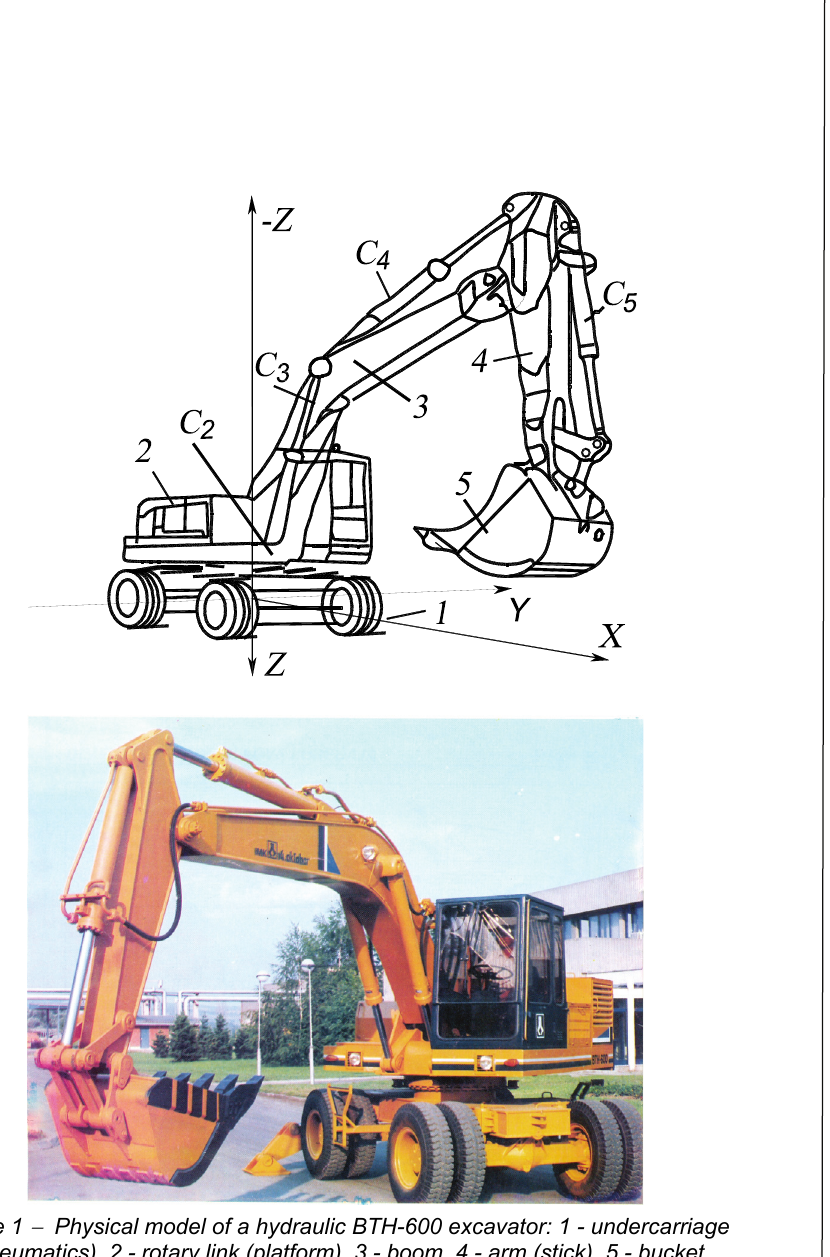
Figure 1  Physical model of a hydraulic BTH-600 excavator: 1 - undercarriage (pneumatics), 2 - rotary link (platform), 3 - boom, 4 - arm (stick), 5 -